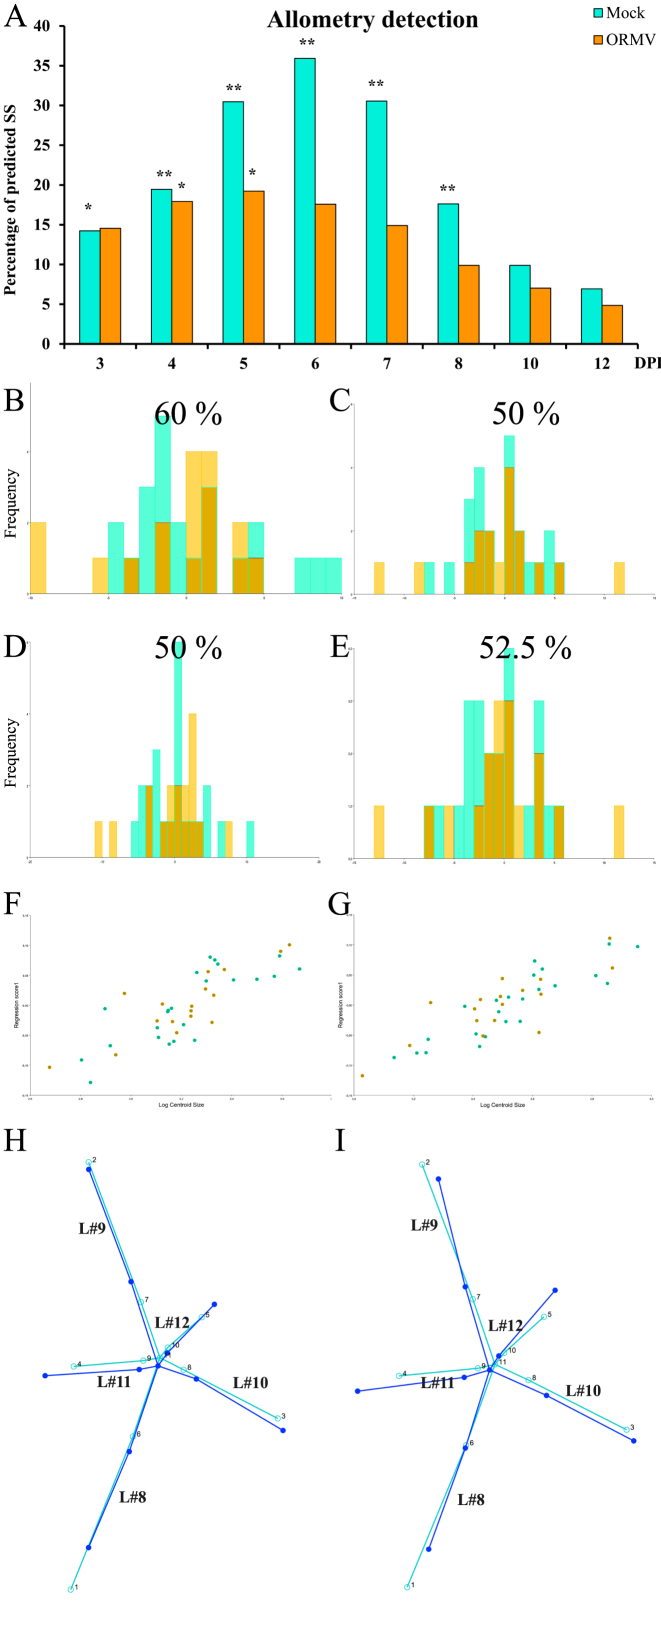
Allometric analyses. (A) Predicted SS from regressions of shape onto ln(CS) for each treatment and DPI. P values were corrected using Holm sequential test (α = 0.05). * = P < 0.05; ** = P < 0.01. Allometric analyses for (B, D, F, H) 3 DPI and (C, E, G, I) 4 DPI (mock = bluish green; ORMV = orange). Cross-validated DAs before (B-C) and after (D-E) size correction with percentages of correct assignments above each graph. (F-G) Scatter plot of regression scores vs. ln(CS). (H-I) Wireframes showing starting mean shape (turquoise) and target shape depicting an increase in one unit of ln(CS) (blue), without magnification.